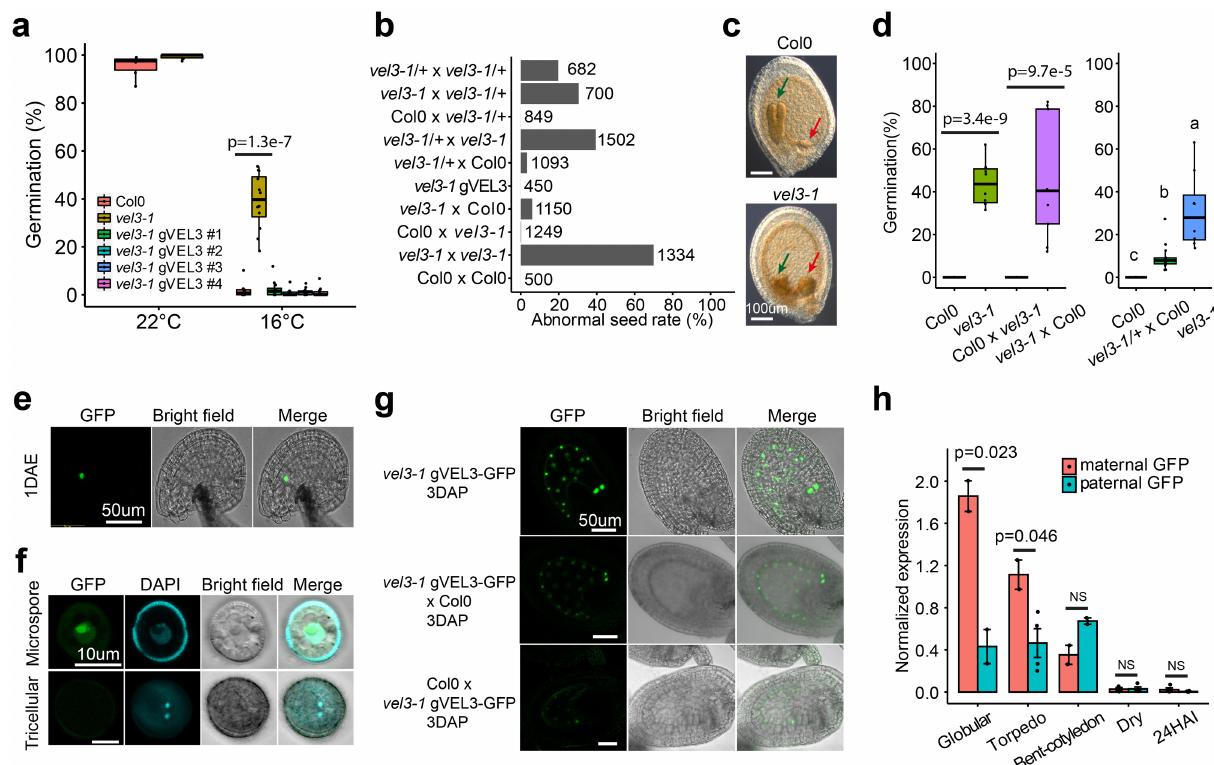
Fig.2|TheroleofVEL3inthecontrolofendospermdevelopmentandmaternal control of primary seed dormancy. a VEL3 is important for seed dormancy establishment when seeds are set at low temperatures. vel3-1 seeds show a clear low-dormancy phenotype, which is complemented by transformation with the VEL3 gene sequence in 4 independent transgenic lines vel3-1 gVEL3 . p -value is derived from the two-sided t -test. Boxplots indicate minimum and maximum values,aswellas25th,50thand75thpercentiles. b Mutant vel3-1 seedsexhibithigh- frequency seed abortion. Reciprocal crosses (always maternalxpaternal in this paper) show that both the maternally derived and paternally derived VEL3 gene copiescanacttopromotenormalseeddevelopment,andthatcomplemented vel3- 1 mutants ( vel3-1 gVEL3 ) show normal seed development. Total number of seeds analyzedforeachgenotypeareshown. c RepresentativeDICimagesofWTand vel3- 1 seeds, demonstrating retardation of embryo development in vel3-1 (blue arrow) and an enlarged chalazal endosperm (red arrow). The experiments were repeated ten times. d Germination of freshly harvested seeds show that maternal VEL3 controls seed dormancy from the female gametophyte. Loss of maternal VEL3 is suf fi cient to affect seed dormancy whereas heterozygous mothers pollinated with WT pollen show an intermediate phenotype. Data represents minimum and